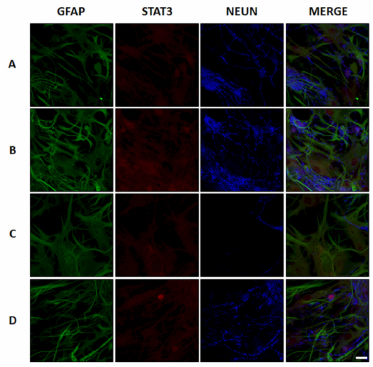
Figure A1. AG490 (25 µ M) inhibition assay. Immunofluorescence representative 40 × images (scale bar 40 × images = 40 µ m) of inhibition assay in primary hippocampal cultures, after 72 h of exposition to ( A ) Vehicle, ( B ) AG490 25 µ M, ( C ) A β O 20 µ M, and ( D ) AG490 + A β O. Total STAT3 expression (Alexa 555), astrocytes with GFAP (Alexa 488), and neurons with NeuN (Cy5) were monitored. Although AG490 did not promote evident changes in STAT3 expression, it seems to prevent neuron loss in cultures